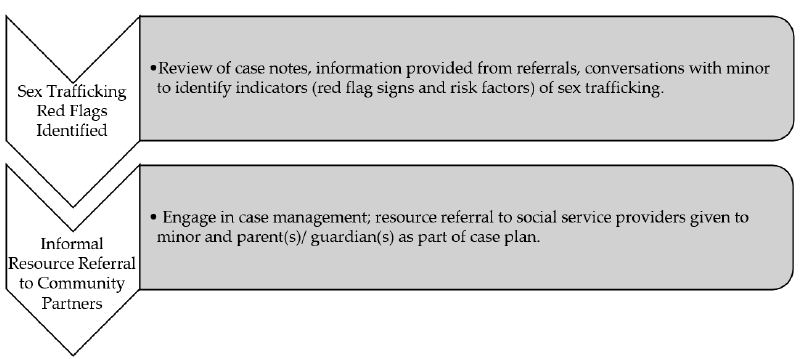
Figure 2. Process in Juvenile Justice System Study Site B.